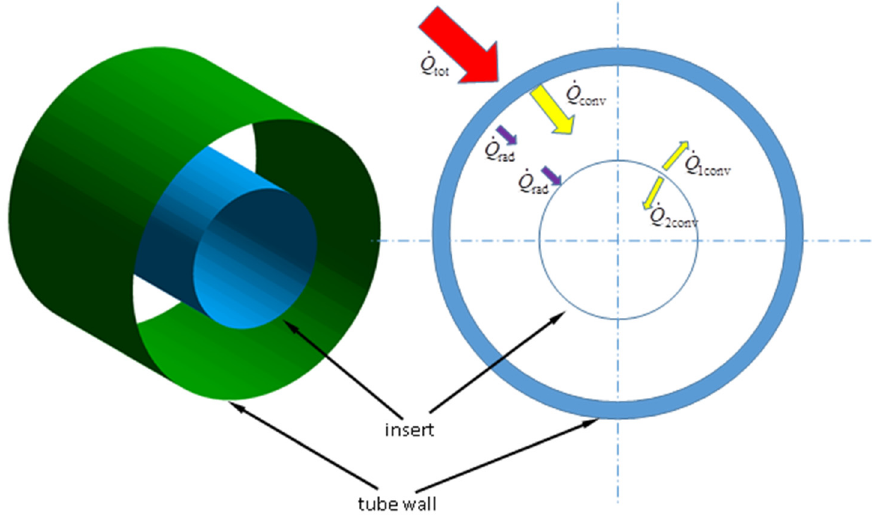
Figure 1. A fragment of a pipe with an insert and a schematic view of heat